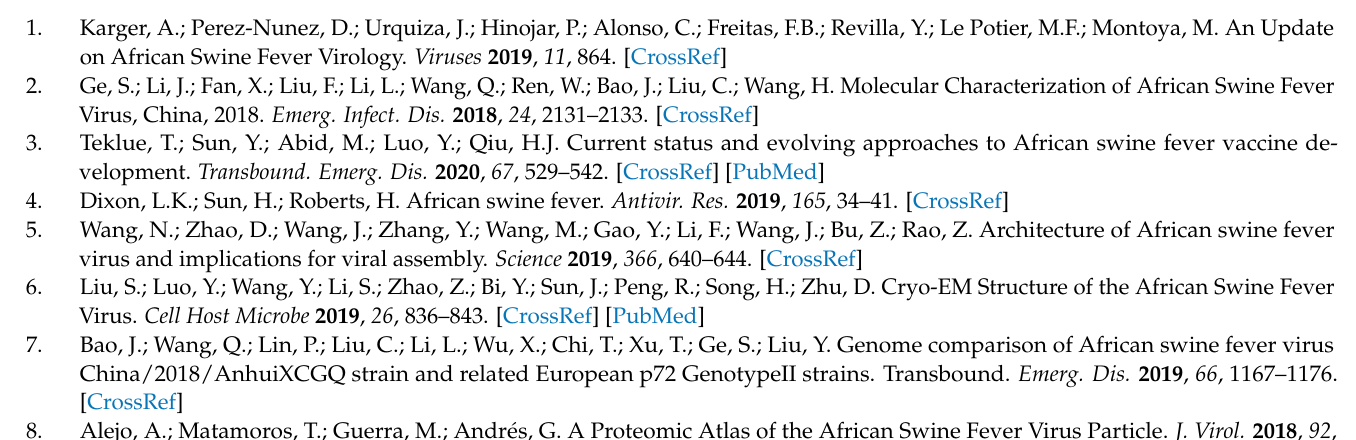
by Western blotting, Table S1: PCR Primers, Table S2: Synthesized peptides for epitope identification, Table S3: dUTPase Sequence ID information details in genetic evolution